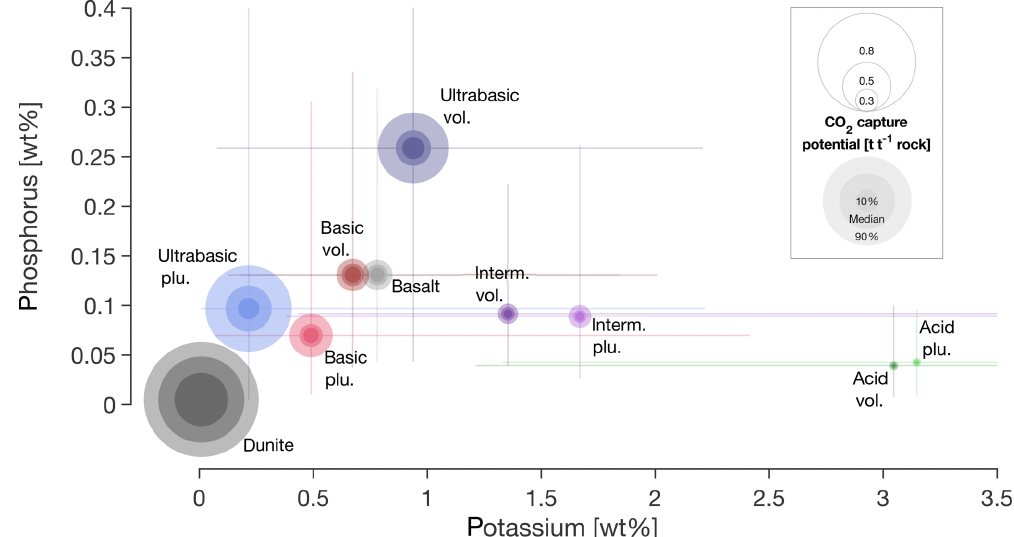
Figure 2. The averaged relative K and P contents of igneous rocks (middle point: median; whiskers: 10th and 90th percentiles, some cutoff at extreme ends for better graphic representation), classified by SiO 2 content (ultrabasic: < 45%; basic: 45%–52%; intermediate: 52%–63%; acid: > 63%). The circles indicate their potential to capture CO 2 . Statistical data are from the GEOROC database (Sarbas, 2008), details in Sect. S3. Documentation on CO 2 capture potential calculation in Sect. S4. A map with the global distribution of all classes is available in Sect. S5. Basalt and dunite were added separately as reference for commonly discussed rock